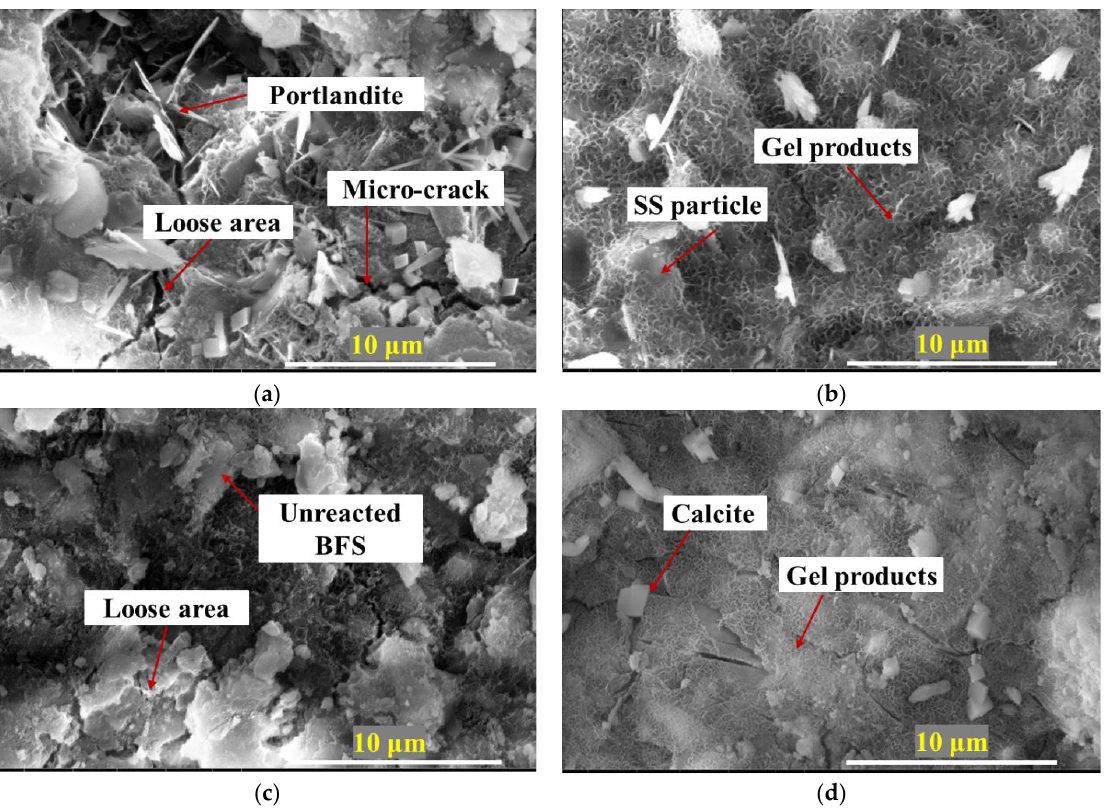
Figure 10. SEM micrographs ( a ) Raw-3%, ( b ) V10-3%, ( c ) V8-1%, ( d ) V8-5%.